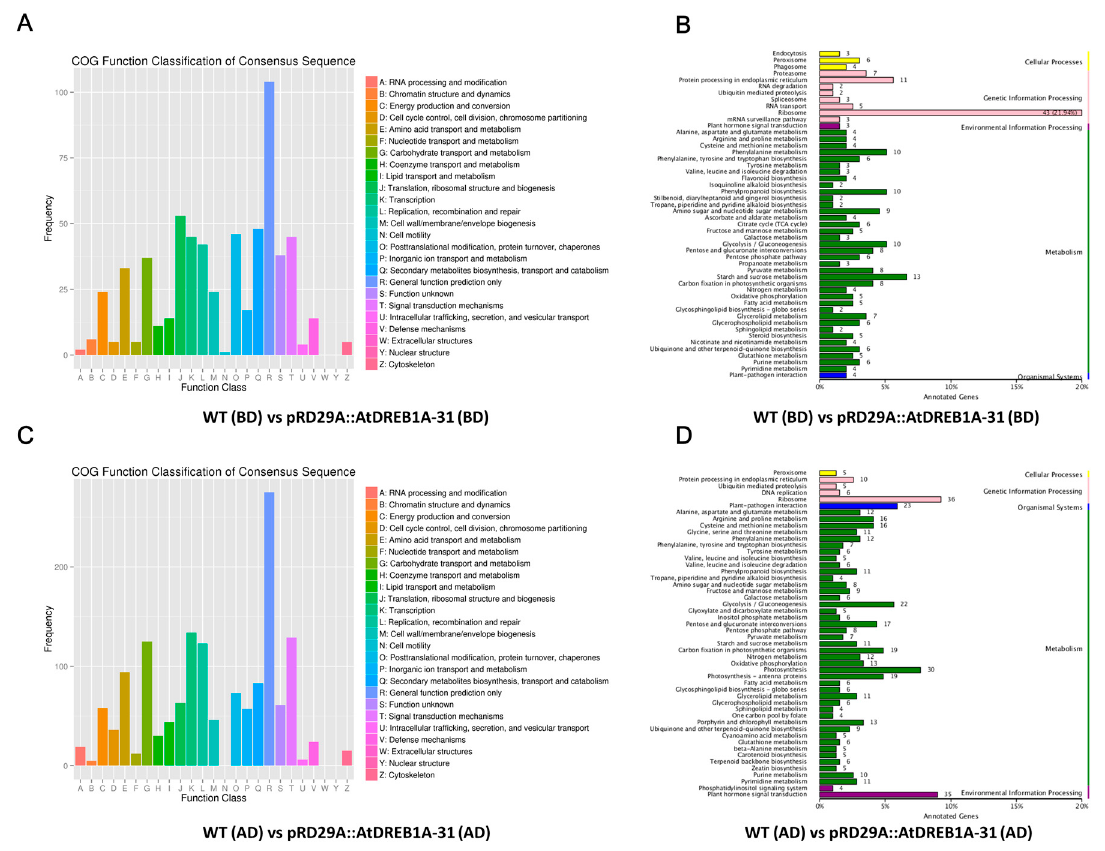
Figure 5. COG and Kyoto Encyclopedia of Genes and Genomes (KEGG) classification of DEGs in the comparisons of WT and AtDREB1A transgenic plants before and after drought treatment. ( A , B ) WT (BD) versus pRD29A::AtDREB1A-31 (BD); ( C , D ) WT (AD) versus pRD29A::AtDREB1A-31 (AD). WT, wild type; pRD29A::AtDREB1A-31, pRD29A::AtDREB1A transgenic line 31. BD, before drought; AD, after six days of drought.